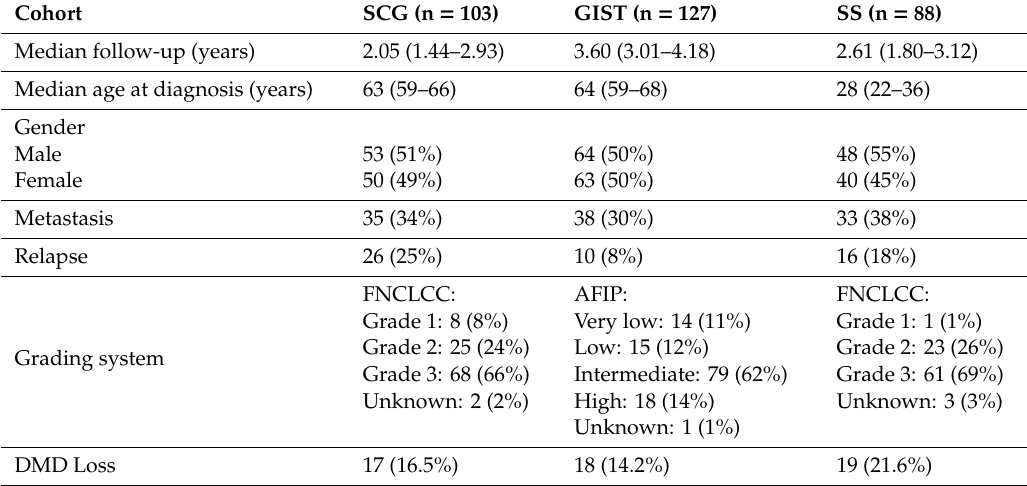
Table 1. Cohort description. SCG: sarcomas with complex genetic profiles GIST: gastrointestinal tumor; SS: synovial sarcoma.